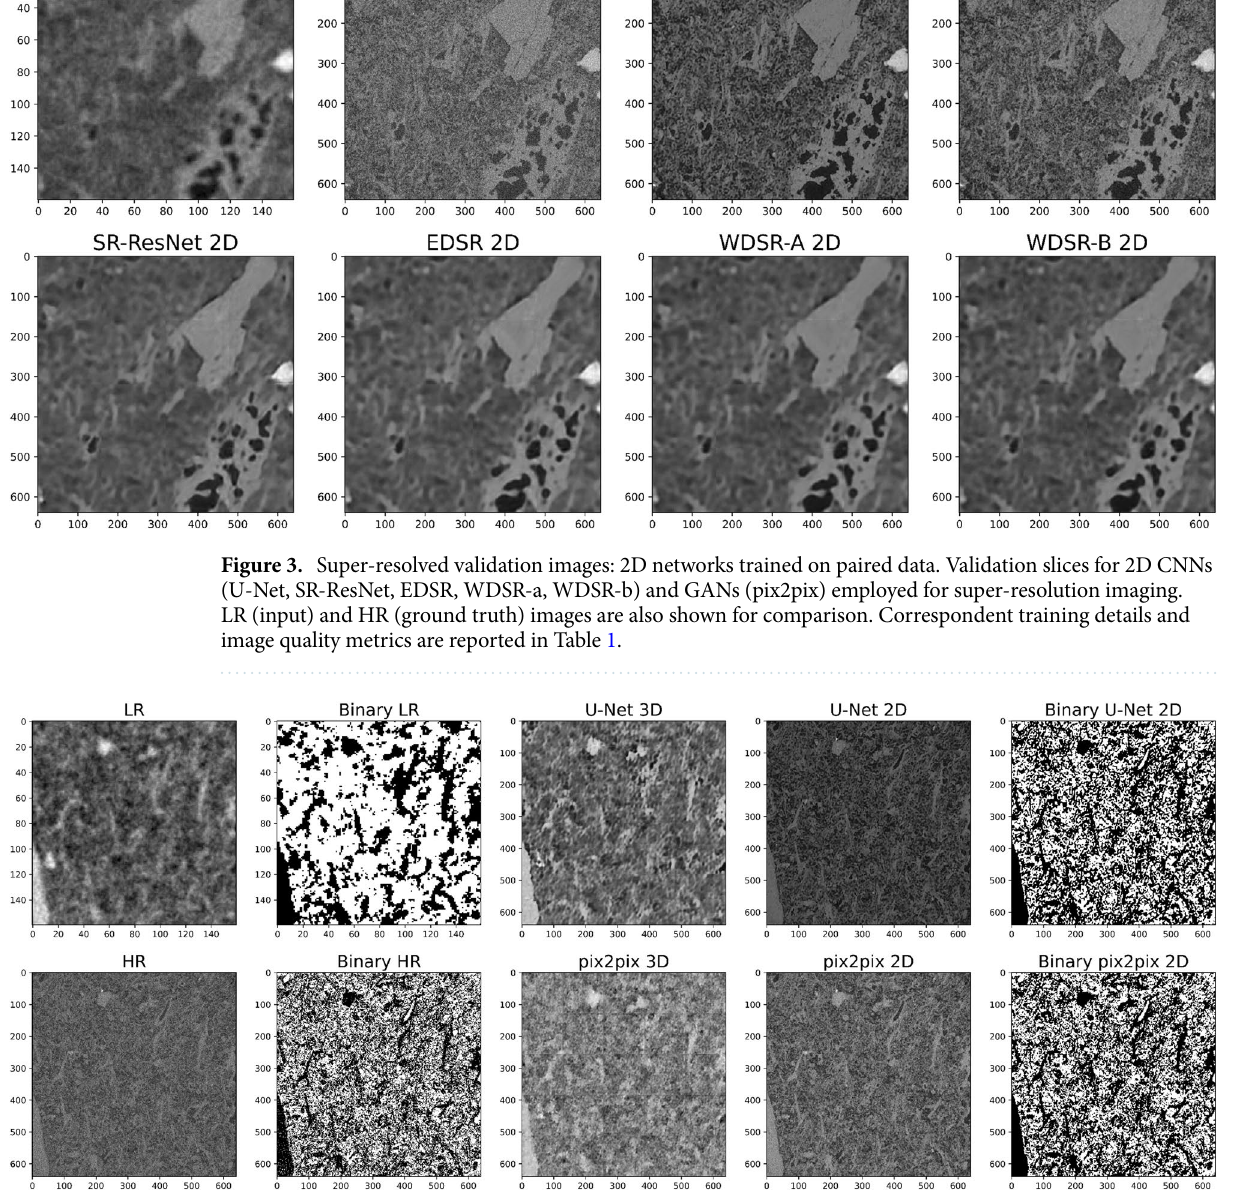
Figure 4. Super-resolved validation images: 2D vs. 3D networks trained on paired data. The resulting best 2D models, pix2pix and U-Net, were trained both in 2D and 3D. LR (input) and HR (ground truth) images are also shown for comparison. Correspondent training details and image quality metrics are reported in Table 1. For LR, HR and validation data from 2D networks, which outperformed the corresponding 3D models, also segmented (binary) images are